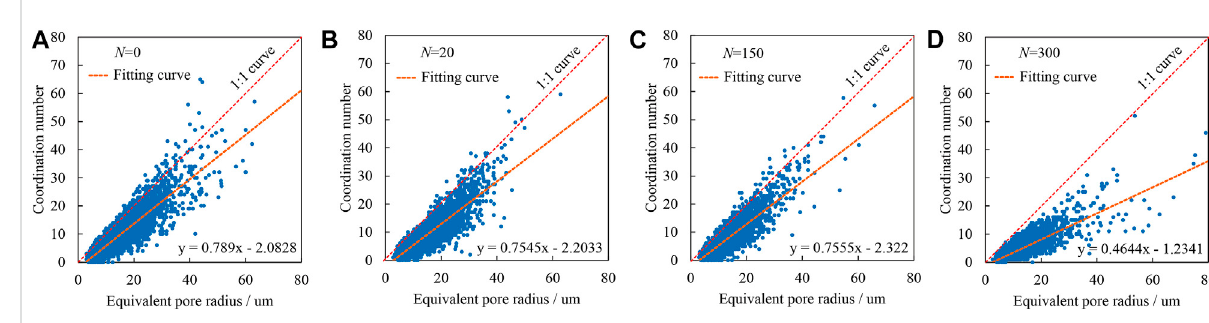
Coordination number distributions and the relationship between coordination number and equivalent radius.